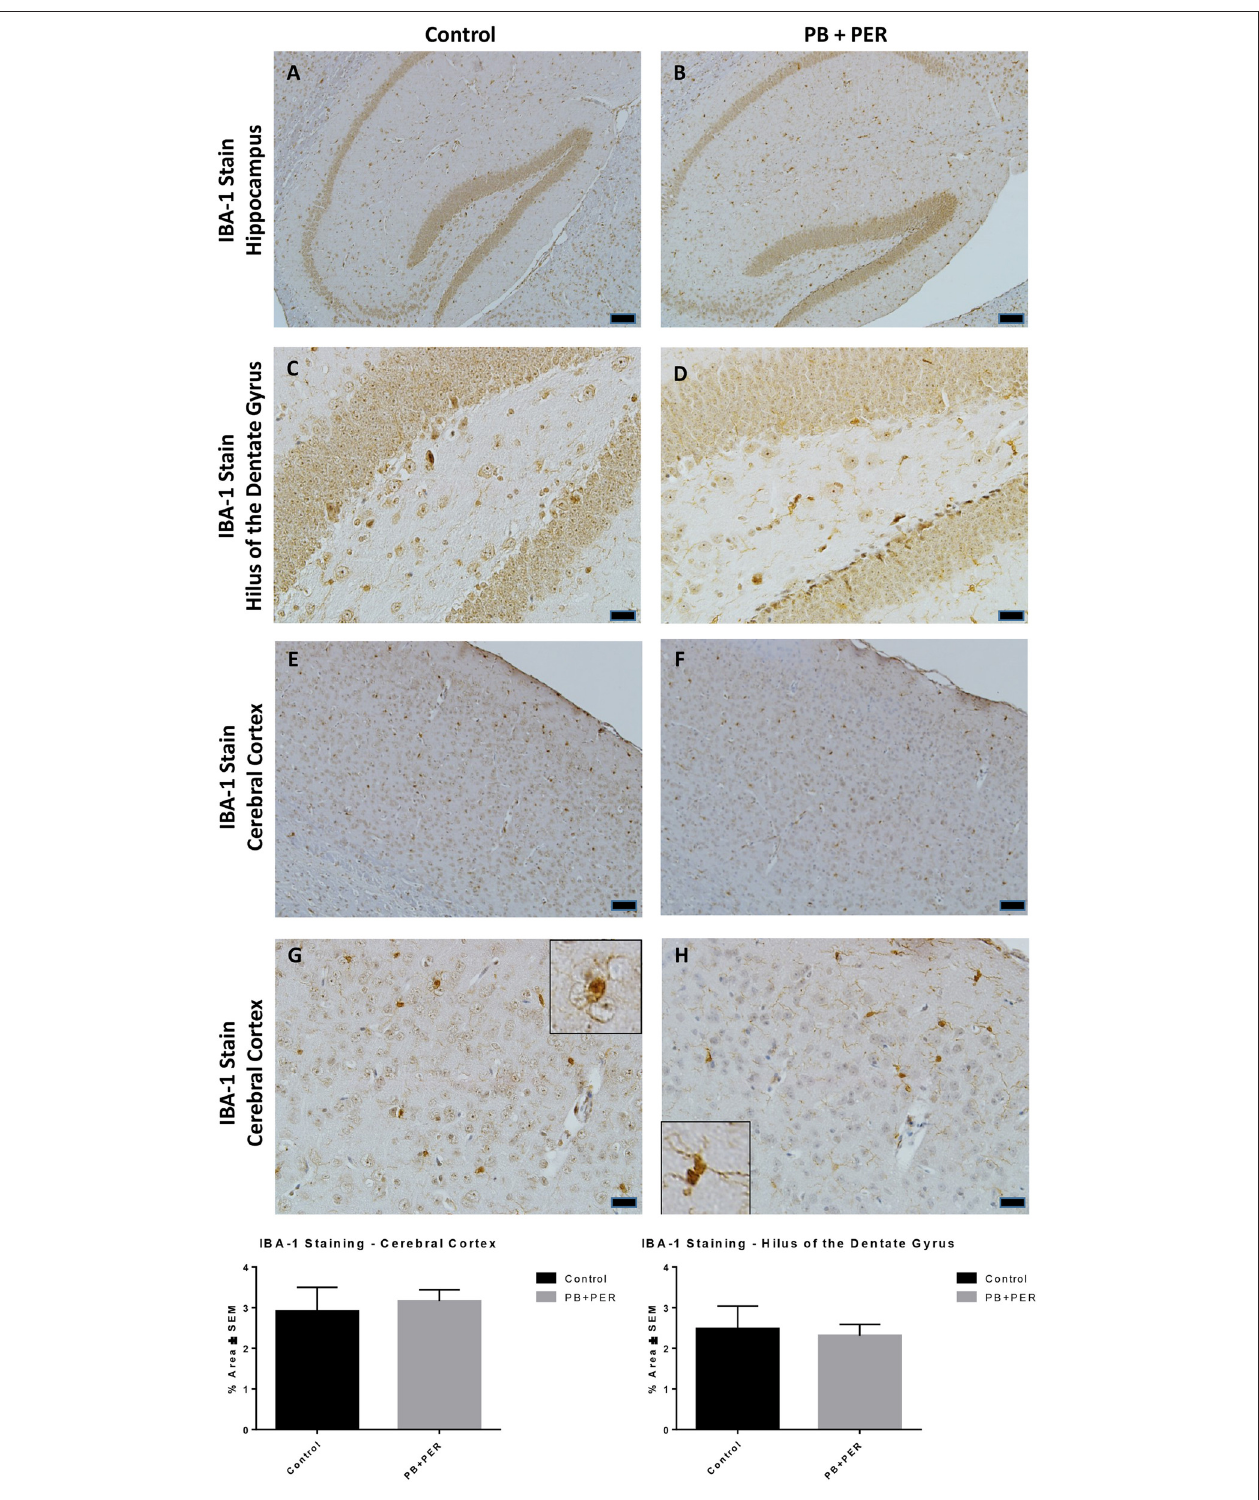
FIGURE 9 | PB + PER exposure did not alter microglial levels in hippocampi and cortices of mice, 22.5 months post-exposure. The IBA-1 stain showed no differences between exposed (B,D) and control (A,C) mice in the hippocampi and the cerebral cortices of exposed (F,H) and control (E,G) animals. Insets in (G) and (H) represent magnified images of ramified and resting microglia in both control and PB + PER exposed mice, respectively, at 22.5 months post exposure to GW agents. Representative images used 10X (A,B,E,F) , and 40X (C,D,G,H) objectives, scale bars represent 100 and 20 µ m, respectively. Histograms depict the quantification of the IBA-1 stain in the hippocampi and cerebral cortices from control and exposed mice as % Area per microscopic field.